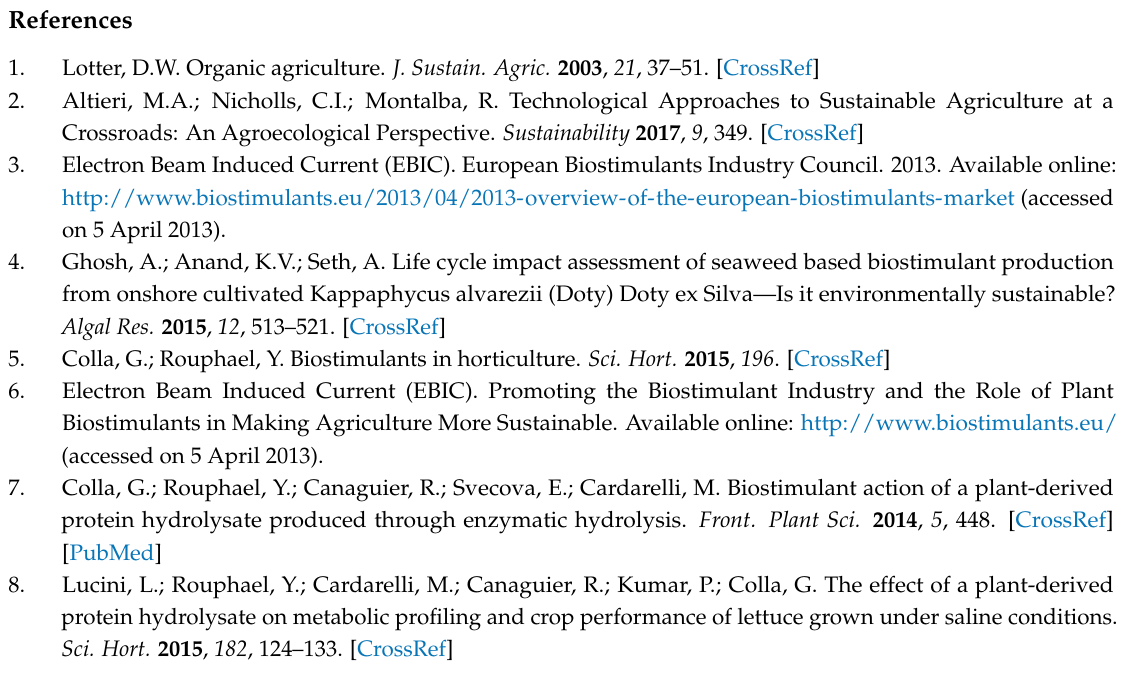
Figure 5. Energy consumption resulting from the difference between enzymatically-produced protein hydrolysate from lupine grains and chemically-produced protein hydrolysate from leather